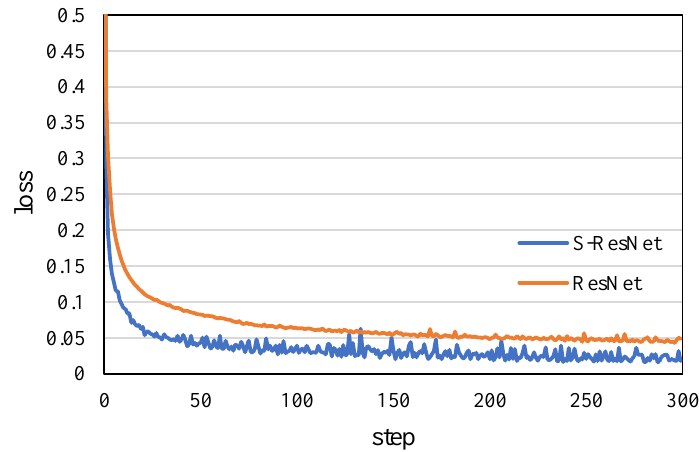
Figure 15. The change of the loss of the two IDSs when training models.